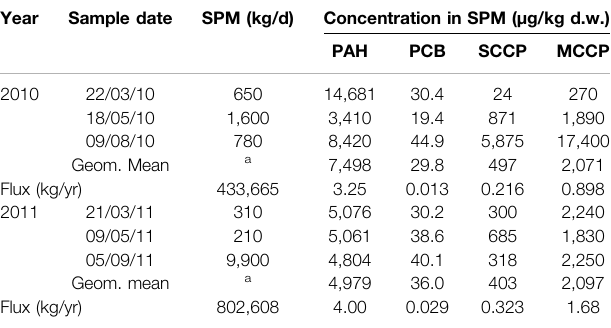
TABLE 1 | Contaminant load transported by the Aker River to the Oslo